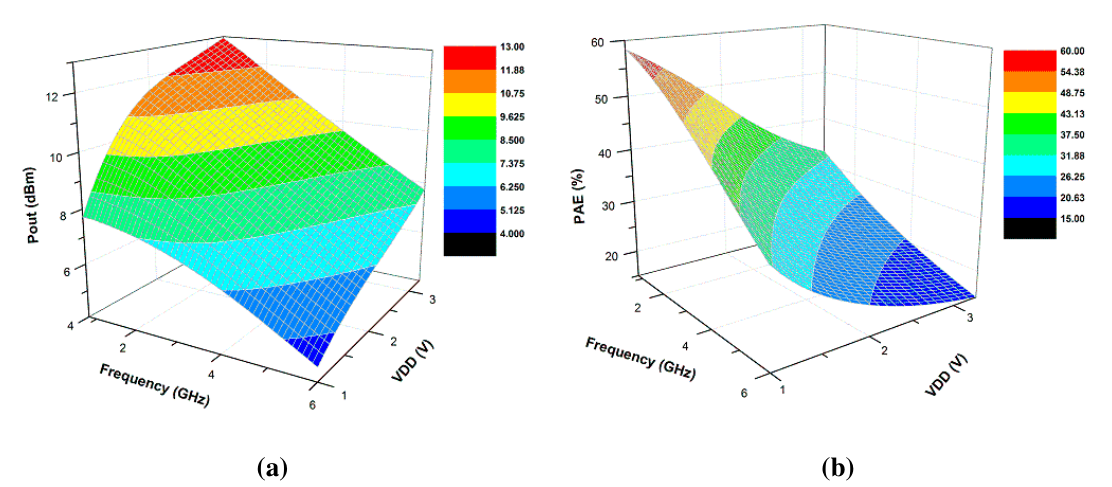
Figure 5. ( a ) Supply voltage and frequency versus output power; ( b ) supply voltage and frequency versus power-added